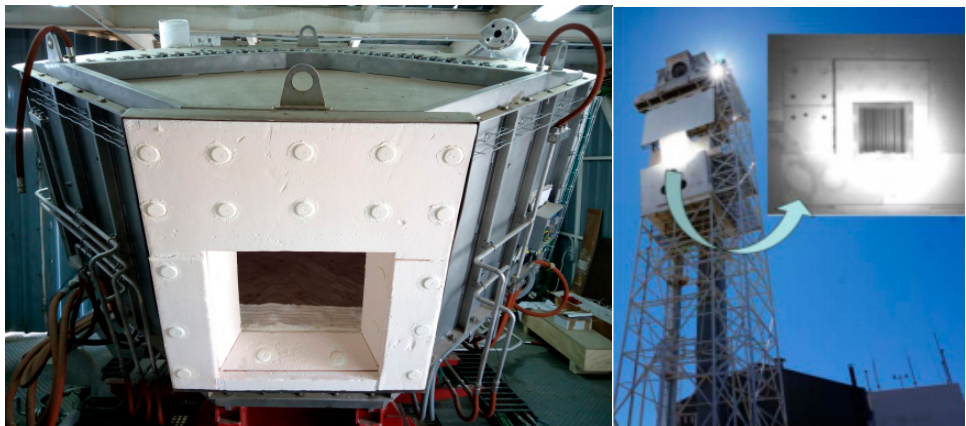
Figure 4. (left) Frontal view of the reactor installed in CRS (Central Receiver Solar) tower plant. (right) View of the reactor being irradiated by CRS field.